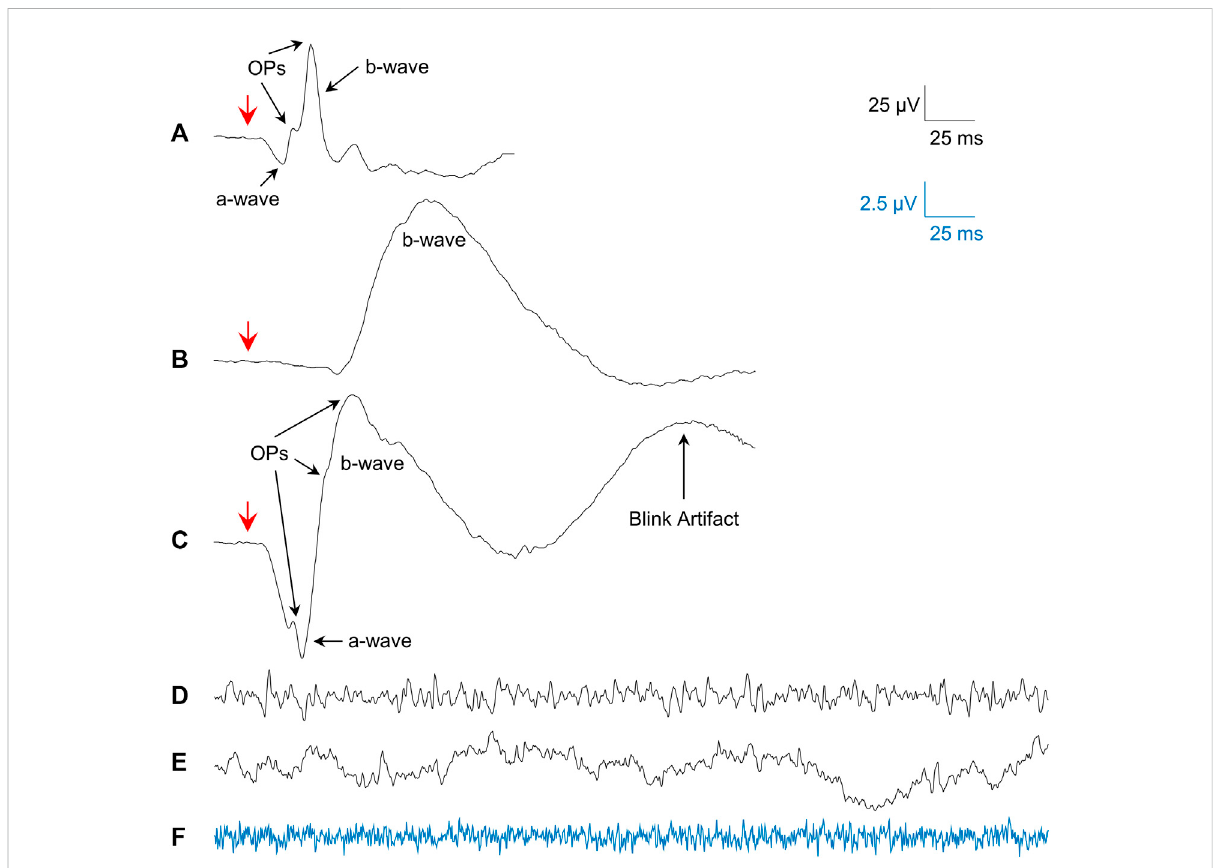
FIGURE 1 Examplesofthesignalsstudied. (A) Meanphotopic3.0 cd s m − 2 fERGfromallsubjects. (B) Meanscotopic0.005 cd s m − 2 fERG(pure-rod)from all subjects. (C) Mean scotopic 1.0 cd s m − 2 fERG (mixed rod-cone) from all subjects. (D) Single sample of a photopic rsERG with 30 cd m − 2 white background. (E) Single sample of an EEG (forehead electrode) with 30 cd m − 2 white background. (F) Single sample from electrode in saline